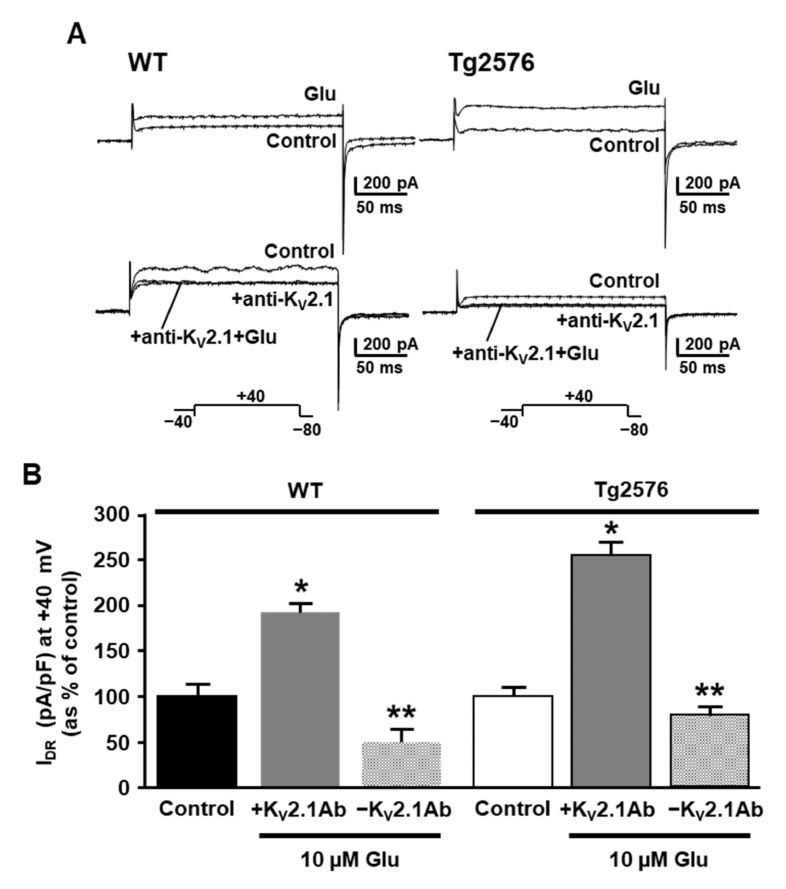
Figure 5. Effect of the anti-K V 2.1 monoclonal antibody on the positive modulation of I DR by glutamate in WT and Tg2576 primary hippocampal neurons. ( A ) Superimposed representative traces of I DR